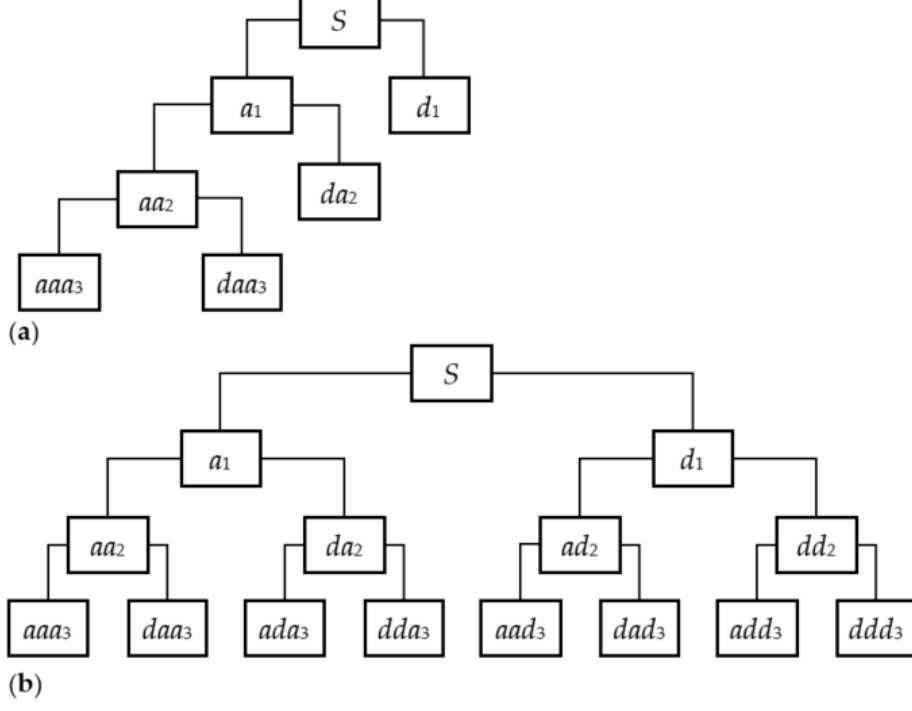
Figure 1. Three-layer decomposition. ( a ) Wavelet; ( b ) Wavelet